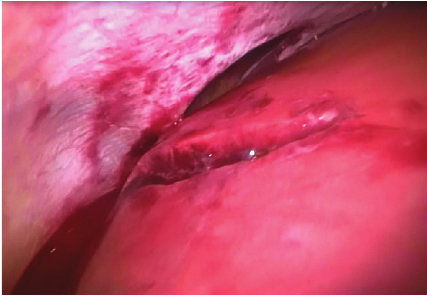
Figure 2: Laparoscopic view of diaphragm rupture and liver